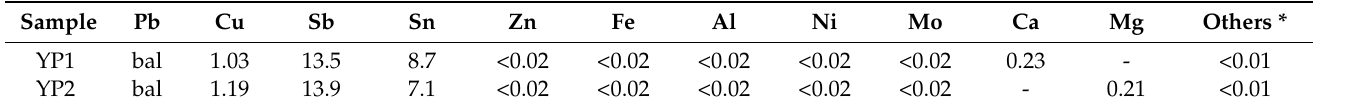
Table 1. Chemical composition of alloys